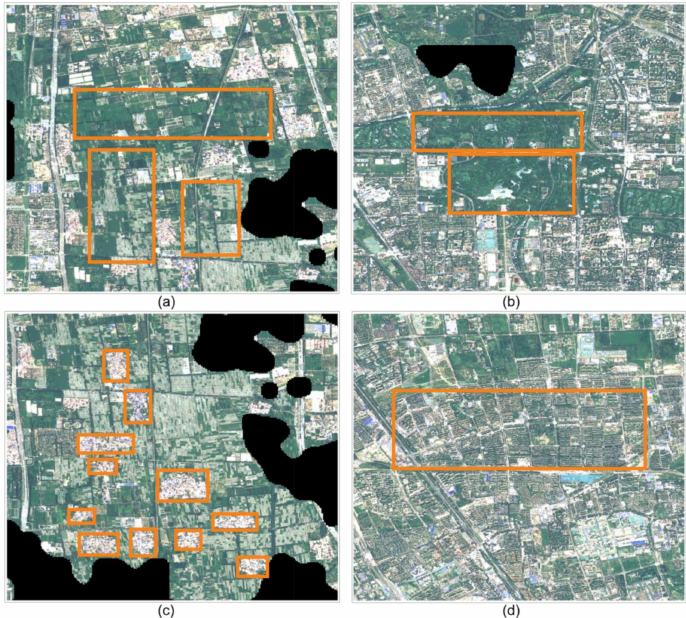
Figure 2. Examples of manually interpreted land-use/land-cover categories from remote sensing imagery, indicated with orange boundaries. ( a ) Rural vegetation. ( b ) Urban greenspace. ( c ) Villages. ( d ) Residence.